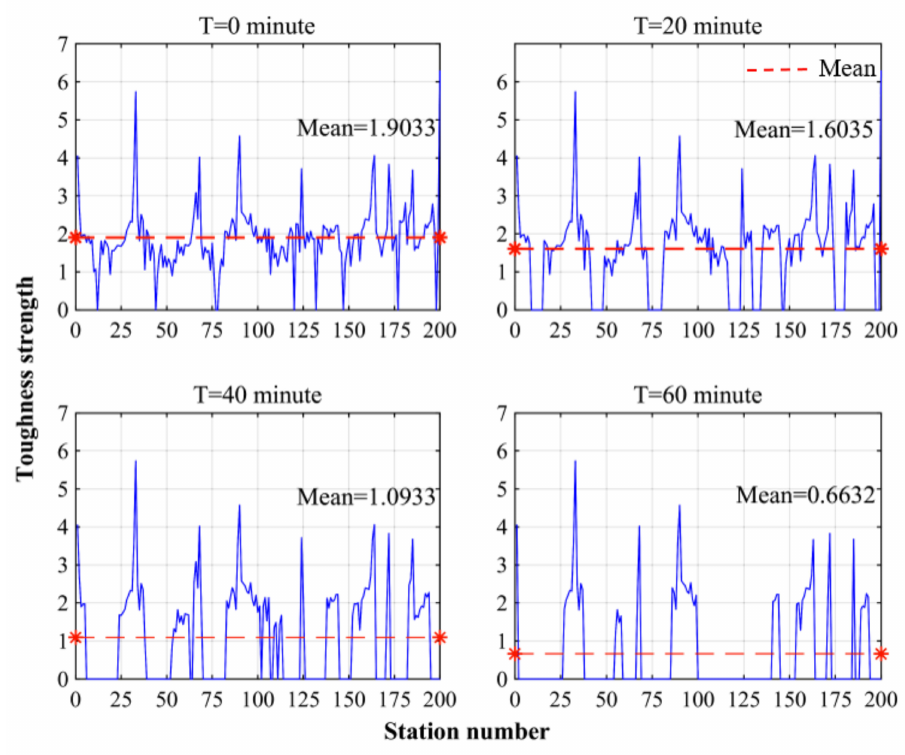
Figure 15. Nodal toughness strength variation